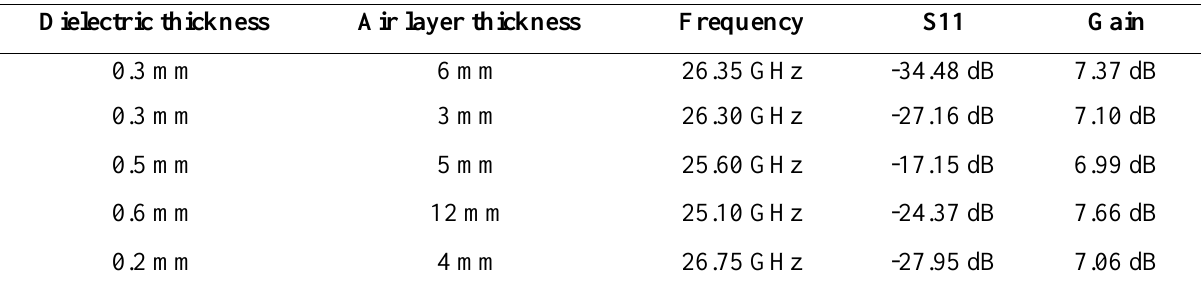
Table 3. Changing dielectric and air